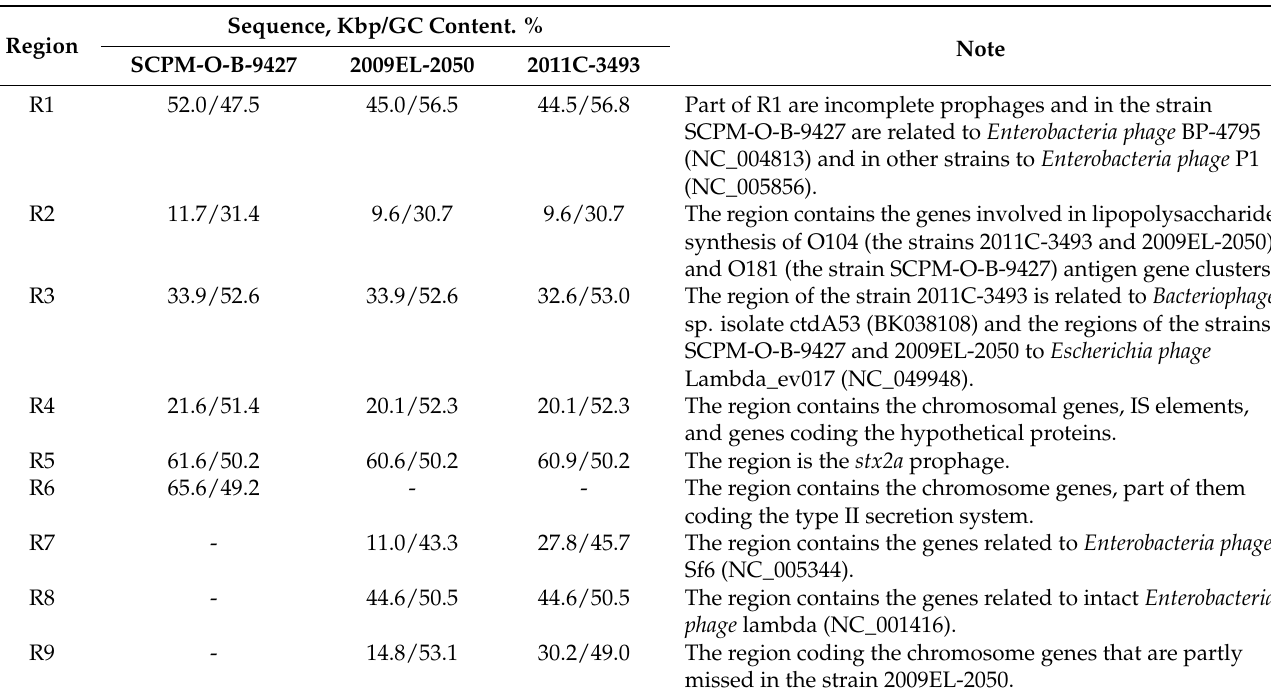
Table 3. Feature of unique regions of EAHEC strains SCPM-O-B-9427, 2009EL-2050, and 2011C-3493 detected using